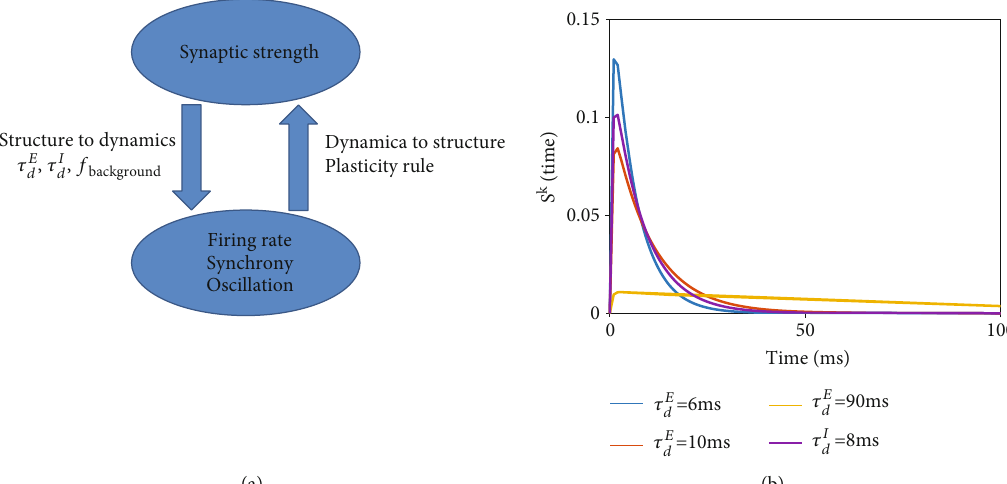
Figure 1: Schematic diagram of the study. (a) A paradigm of the interaction between network structure and dynamics. Branch I (left): synaptic weights in fl uence the circuit dynamical properties, and this in fl uence depends on other dynamical parameters such as synaptic time constant ( τ E , τ I ) and background input f . Branch II (right): the circuit dynamics in fl uence the synaptic weights through background d d plasticity rule. (b) Illustration of the synaptic time course S k ð t Þ , k = E , I in Eq.(3) with di ff erent decay time τ k